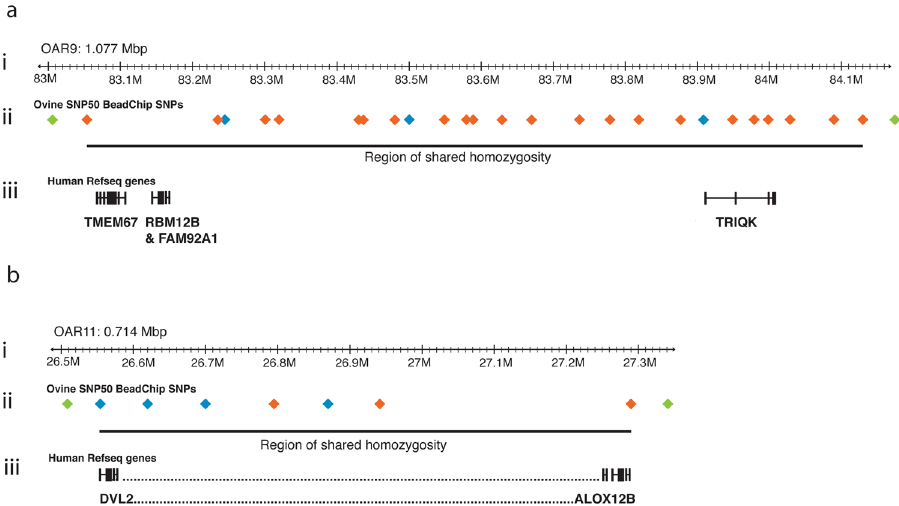
Figure 3. Homozygosity mapping depicting the largest homozygous regions shared by affected lambs in flocks A and B. The relevant portions of sheep chromosomes 9 and 11 are shown in ( a ) and ( b ), respectively. (ai and bi) Ruler segments depict the portion of either chromosome 9 (ai), or chromosome 11 (bi) of the ovine genome assembly v3.1 sequence. (aii and bii) colored diamonds show SNP locations on the SNP50 BeadChip in relevant regions on chromosomes 9 and 11. Green diamonds show heterozygous SNPs outside the homozygous regions. Orange diamonds show homozygous SNPs in all affected lambs. Blue diamonds show SNPs that were heterozygous in one or more affected lambs. (Note that 25 SNPs in the homozygous region in aii, and 7 SNPs in bii are depicted in this figure, but originally 26 SNPs and 8 SNPs, respectively, were identified in the v1.0 sequence - see Supplementary Tables 1–3). Regions of shared homozygosity are depicted below the SNPs by a black line. (aiii) The black boxes show the human reference sequence genes located in the regions of shared homozygosity based on comparative genomic maps of chromosomes 9 and 11. The TMEM67 gene is indicated on chromosome 9. On chromosome 11 only two genes are shown, DVL2 and ALOX12B , with the dotted line in between representing 49 other genes in this